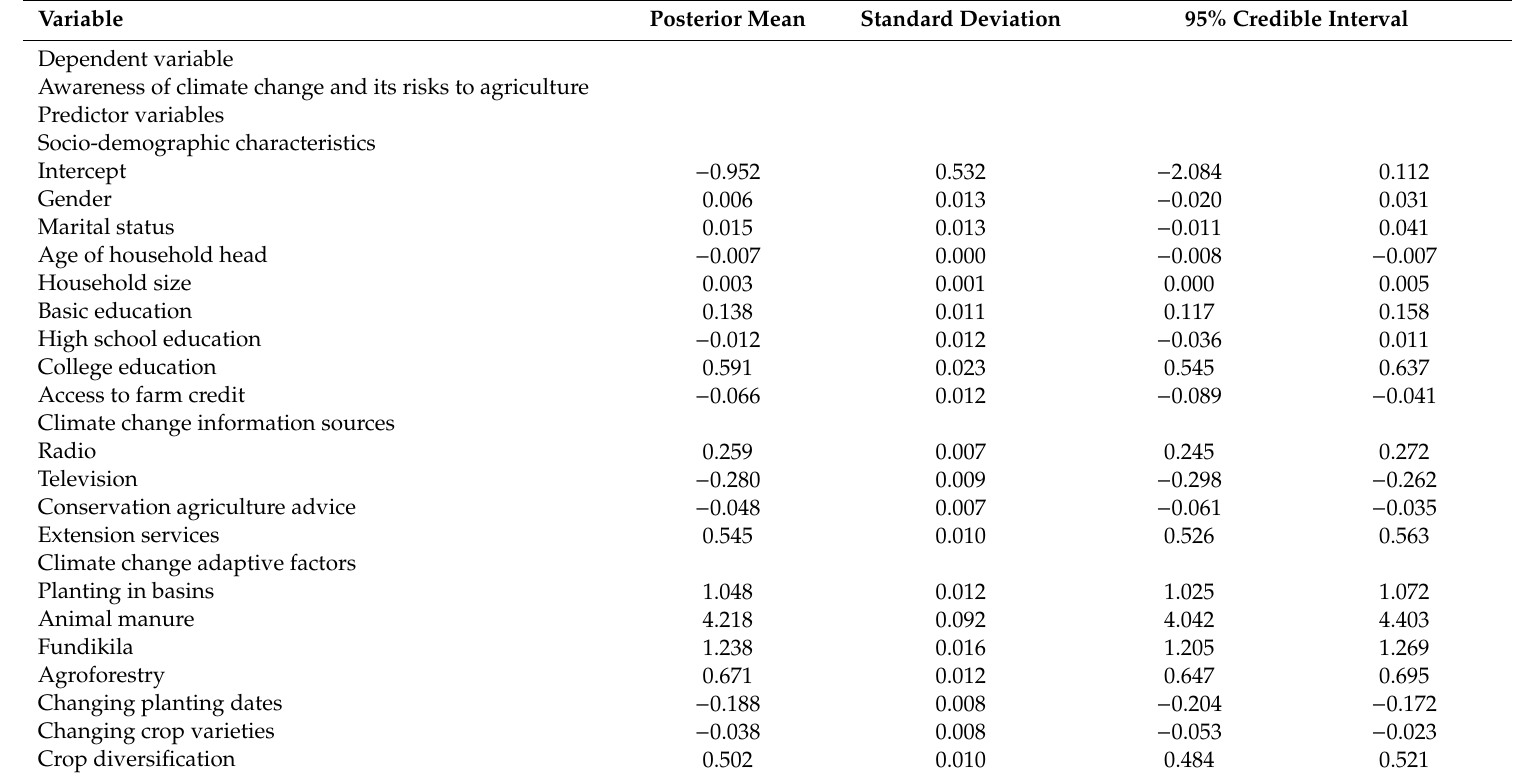
Table A2. Posterior means, standard deviations, and Bayesian 95% credible